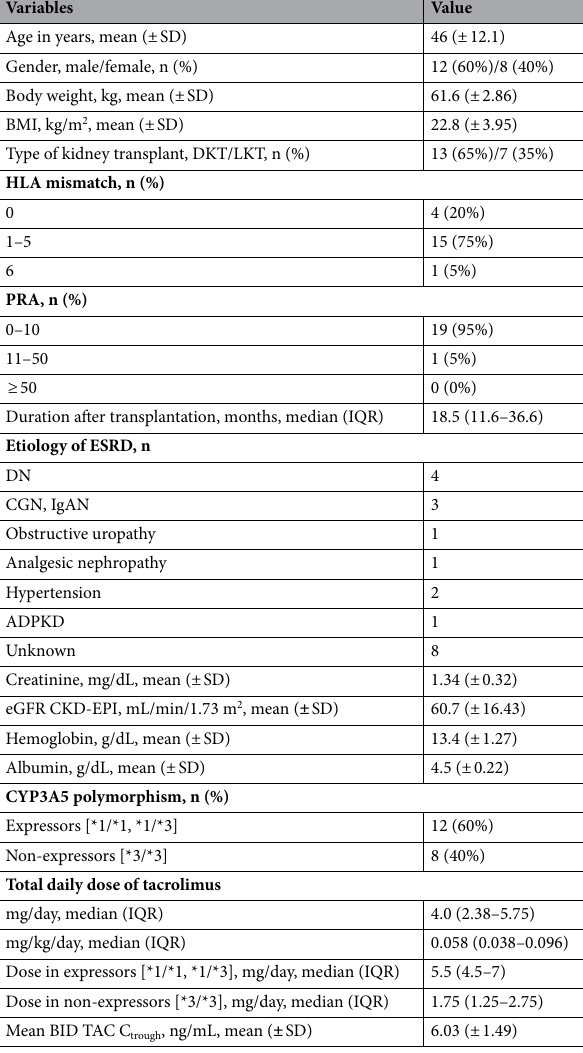
Fig. 3. The average difference between the linear prediction based on C0, C6, and C12 and the actual AUC 0-24 was 0.0 (SD ± 8.4) ng/mL × h, with a 95% limit of agreement extending from − 16.47 to 16.47 ng/mL × h. The scatter of the individual points showed no evidence of bias across the range of the AUC 0-24 . Lin’s concordance correlation coefficient was 0.99. In addition, we further investigated the effects of CYP3A5 genotypic polymorphism on AUC 0-24 and C trough after converting from BID TAC to OD TAC. The CYP3A5 gene alleles were identified in the whole blood by real-time reverse transcription polymerase chain reaction by using forward and reverse primers (F5 ′ -CAT GAC was utilized to identify the allelic variant of CYP3A5 (rs776746). The patients were then categorized according to CYP3A5 genotypic polymorphism: (1) expressor ( CYP3A5 *1/- or CYP3A5 *1/*3 ) and (2) non-expressor ( CYP3A5 *3/*3 ). Twelve of the 20 patients were CYP3A5 expressor while the remaining patients were non-expressor. In the CYP3A5 expressor group, the geometric means (%CV) of AUC 0-24 were 234.5 (26.3%) and 238.5 (23.5%) ng/mL × h for OD TAC and BID TAC, respectively (Table 5). The GMR (90%CI) was 0.98 (0.91–1.05). The geometric mean (%CV) of C trough for OD TAC and BID TAC were 5.77 (24.7%) and 6.74 (25.8%) ng/mL, respectively, with a GMR (90%CI) of 0.86 (0.79–0.93) which fell outside the equivalence ratio (Fig. 4). In the CYP3A5 non-expressor group,